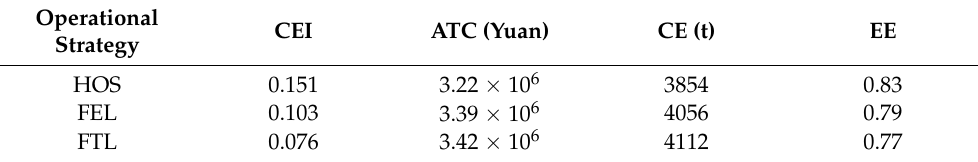
Table 3. The evaluation index optimization results of three operational strategies.